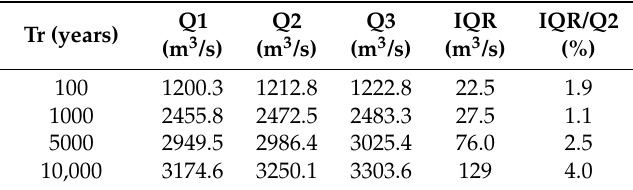
Table 3. Values of the first (Q1), second (Q2), third (Q3) quartiles, the interquartile range IQR, and the relative value of the IQR against Q2, for different return periods (Tr) of maximum outflows. Q1 Tr (years) (m 3 /s)